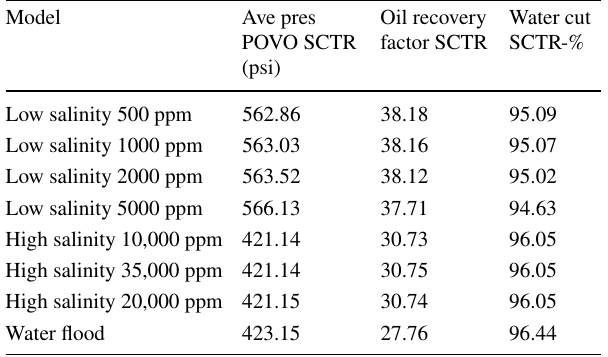
Table 4 Oil retention factors, average reservoir pressures and water cut percentages for the saline water flooding and gel